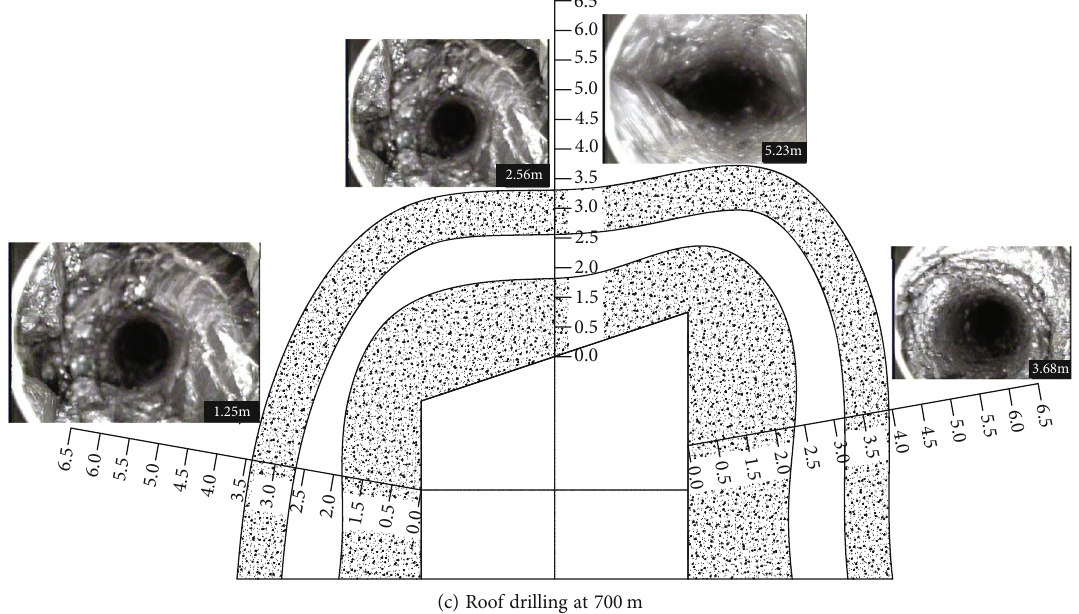
Figure 20: 3206 return airway